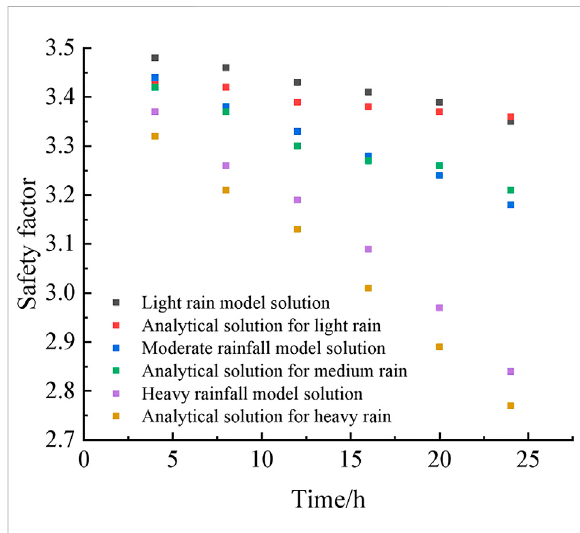
FIGURE 19 Comparison between analytical solution and model